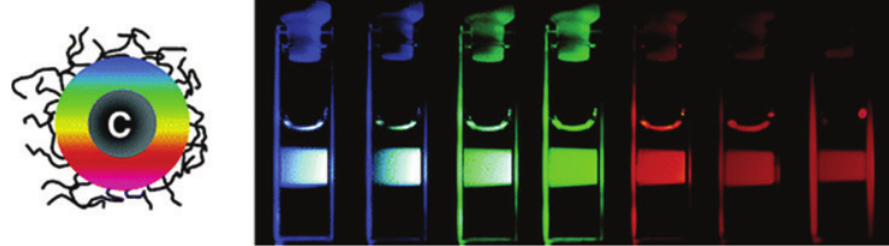
Figure 2: Aqueous solution of PEG1500N-attached carbon dots. Reprinted with permission of Ref. [31]. © Copyright 2006 American Chemical